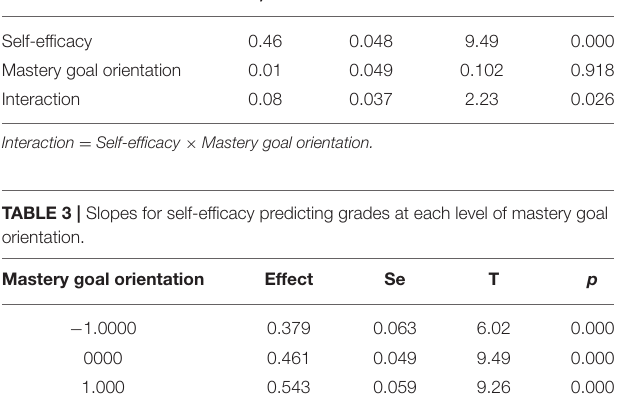
TABLE 1 | Descriptive statistics and intercorrelations. Variable